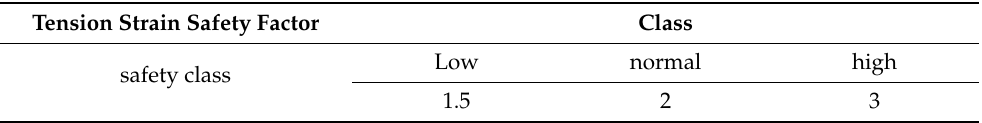
Table 9. Safety classes for tension and associated safety